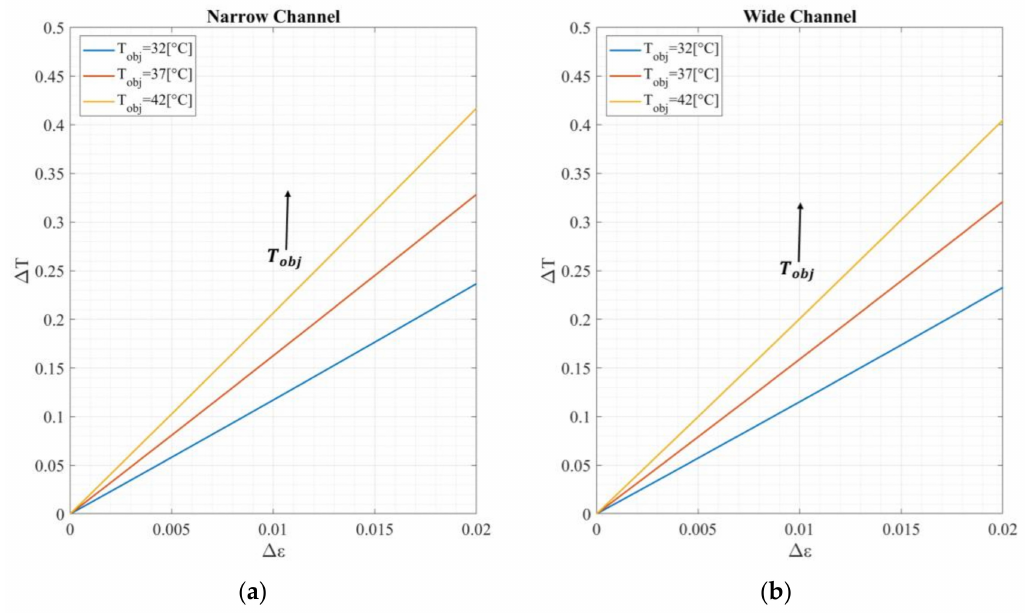
Figure A3. The temperature inaccuracy induced by emissivity inaccuracy up to 0.02 at assumed ambient temperature of 20 ◦ C for the two channels under study: ( a ) narrow bandpass 8–14 µ m; ( b ) wide bandpass 5.5–13.5 µ